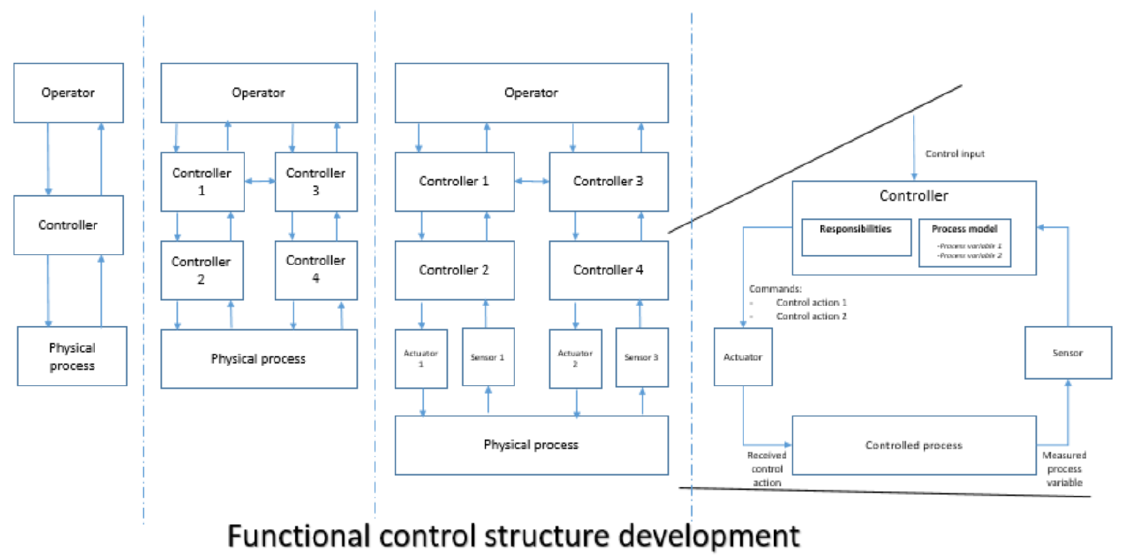
Figure 2. Flowchart demonstrating the steps for developing a control structure (Step 2).